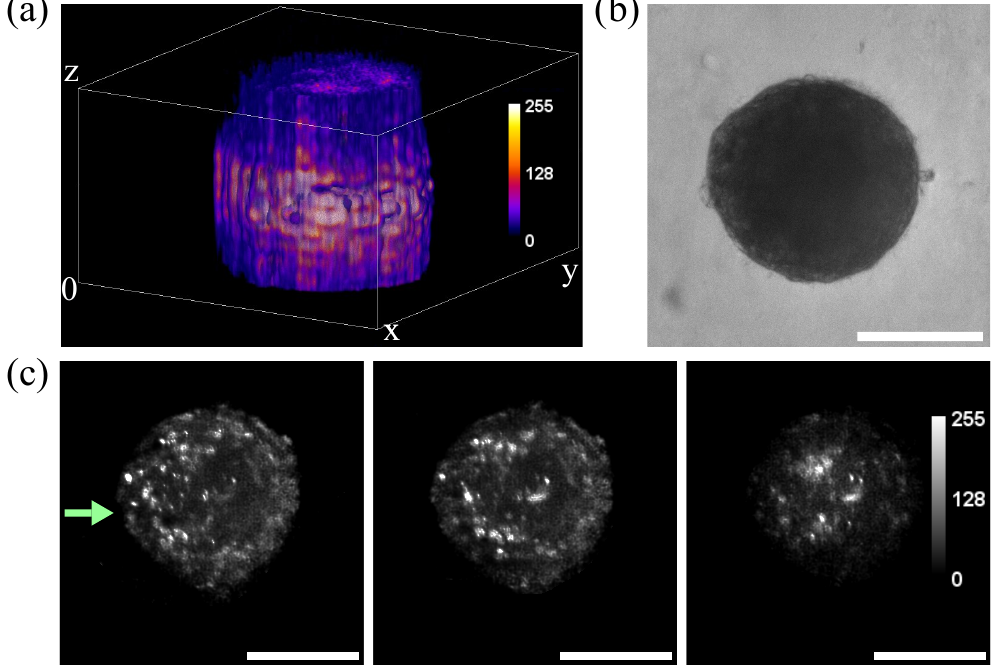
Figure 3. Volumetric reconstruction of spheroids prepared with fluorescent HaCaT/(H2B- GFP) cells and acquired with the custom-made SPIM microscope: ( a ) Reconstruction of spheroid generated using the Fiji plugin Volume Viewer, with volume rendering using trilinear interpolation and Fire look-up table (LUT); ( b ) Bright-field microscopy image of the sample, acquired using the LED in the SPIM; ( c ) Axial cross-sectional cuts of the spheroid at different heights along the z axis. The green arrow represents the direction the light is coming from. Scale bars: 100 µ